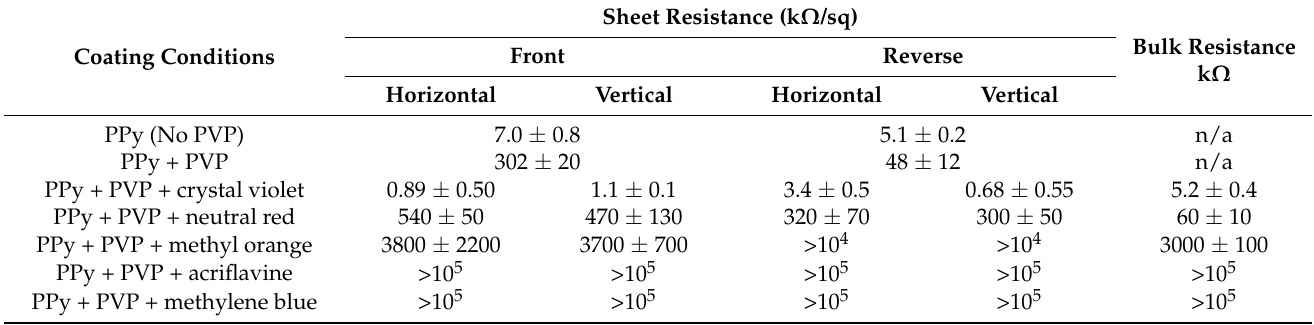
Table 1. Sheet and bulk resistances of leather coated with polypyrrole (PPy) in the presence of PVP and organic